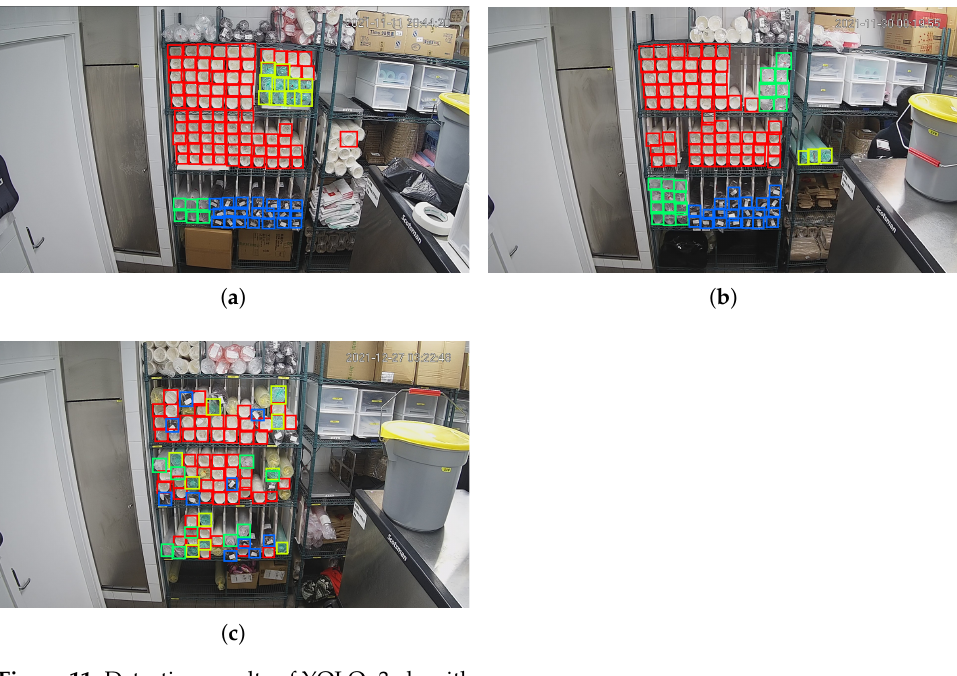
Figure 11. Detection results of YOLOv3 algorithm. Table 4. Counted number and